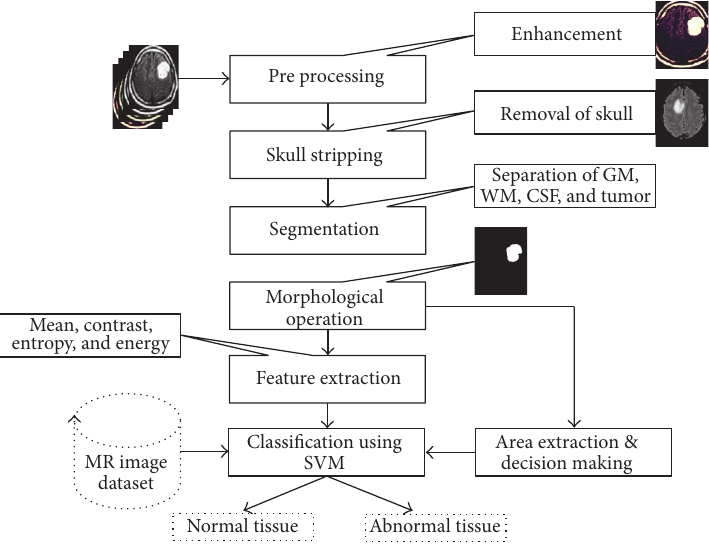
Figure 1: Steps used in proposed algorithm.